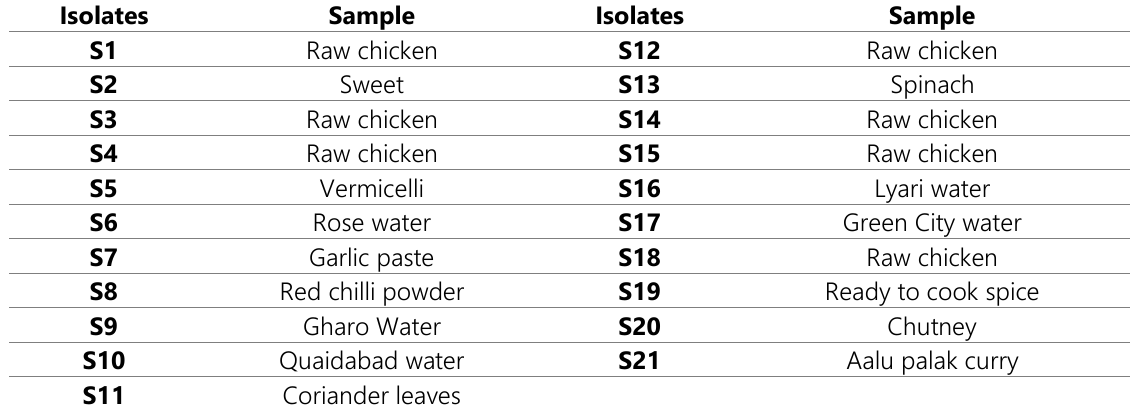
Table 1: Presumptive Salmonella isolates with their respective source (Based on the culture-based method).